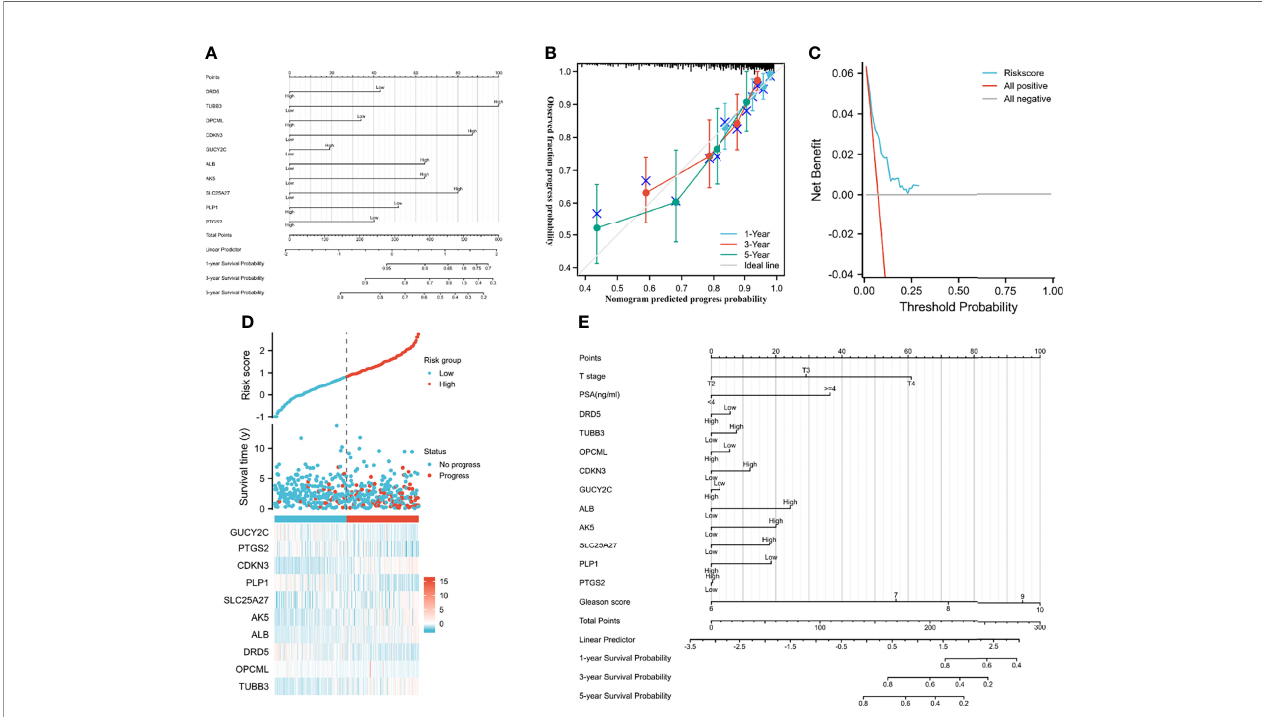
FIGURE 3 | Predictive models and heatmap of risk fator. (A) the nomogram of gene signature; (B) the calibration plot; (C) the result of decision curve analysis; (D) heatmap of risk factor; (E) the nomogram of gene signature and clinical